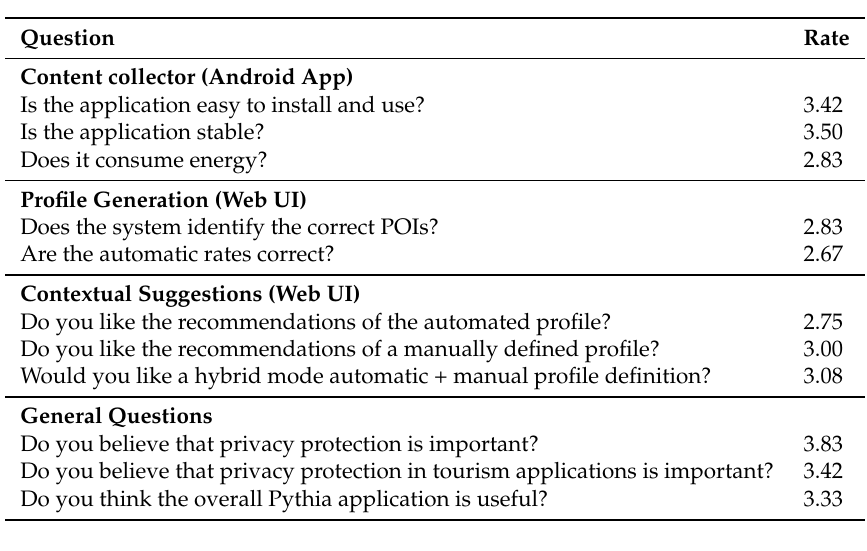
Table 2. A summary of the user feedback questionnaire results. Responses are expressed in a five-point Likert scale, with 0 for disagreement and 4 for agreement. Below is the average of 17